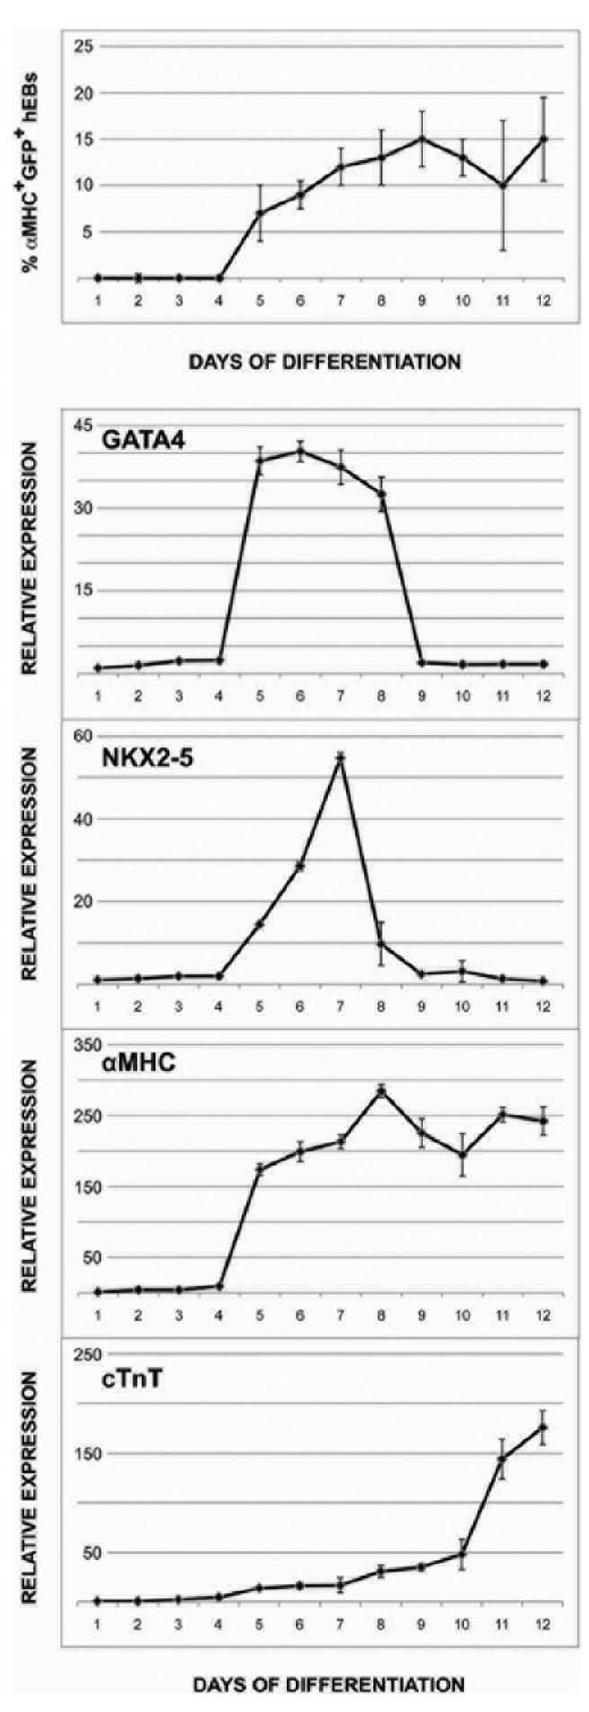
Figure 5. Reporter activation coincides with early cardiogen- esis. a MHC-GFP hESCs were differentiated for 12 days and the number of hMPs (GFP + a MHC + ) cells were scored as a percentage of total hESC number on each day. On days 1–4, before the onset of GFP expression, unsorted differentiating hESCs were analyzed by qPCR. On days 5–12, sorted GFP + hMPs were analyzed by qPCR for expression of cTnT, NKX2- 5, GATA4 and a MHC, relative to undifferentiated hESCs at day 1. Data shown represent mean 6 s.e.m. (N=3). Reporter activation was first observed on day 5, with 15% GFP + ( a MHC + ) hESCs seen by day 9 ( top ). Endogenous a MHC, GATA4 and NKX2-5 expression was observed with activation of the reporter on day 5, while strong expression of cTnT did not appear until day 11 ( bottom